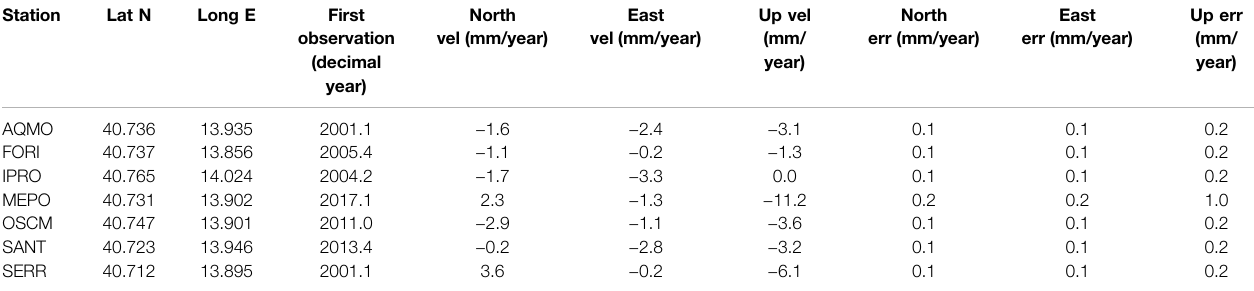
TABLE 3 | cGPS horizontal and vertical velocities for Ischia Island in the time spam 2001 – 2019 (De Martino et al., 2011). Station Lat